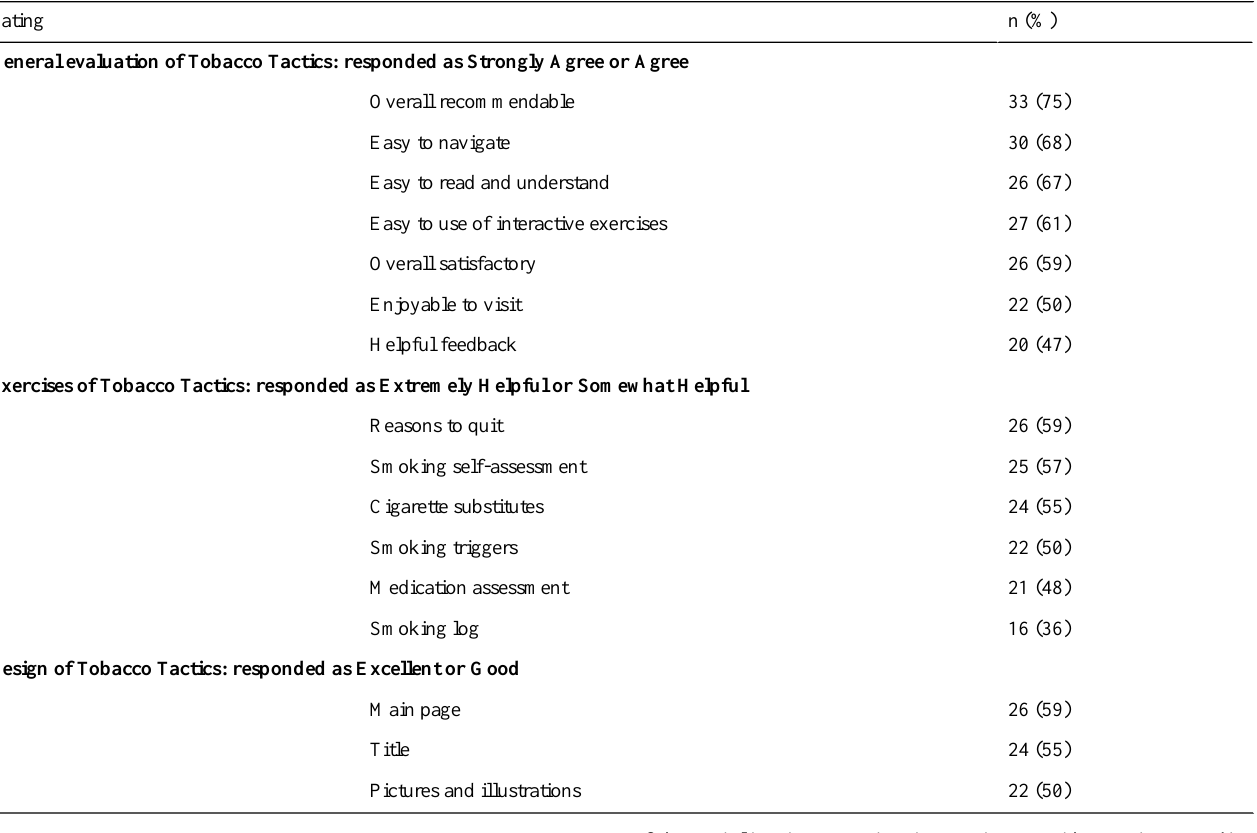
Table 3. Percent of respondents that rated the Tobacco Tactics website as 4 or 5 on a 5-point scale, with higher numbers being better (n=44).